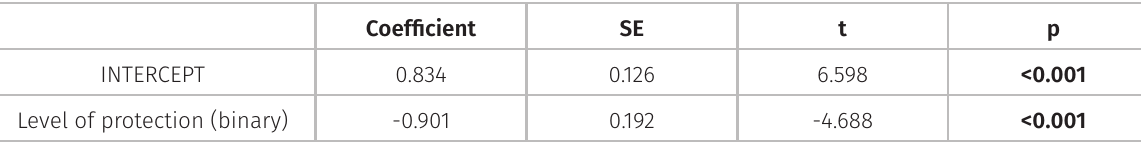
Table V. Statistical results (coefficient estimates, standard error [SE], t value, and p-value) for the best model selected to explain roadkill events of birds in the unprotected landscape in Alto Paraíso de Goiás, Goiás state, Brazil. Significant values at ɑ<0.05 are in